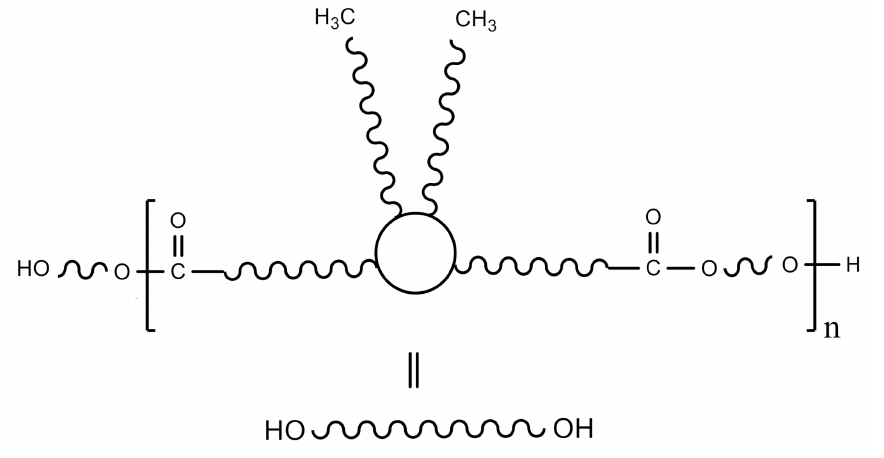
Figure 2. The chemical structure of Priplast 3294. The additives to formulate the printing pastes were supplied by Color Center, S.A. and are: Defoamer PR (defoamer, mineral oil-based), Complex DG (diethylene glycol-based, runnability improver), DMEA (dimethylethanolamine, neutralizing agent), and Thickener L-120 (polyacrylic acid, associative thickener). A commercial aliphatic polyether-urethane waterborne dispersion from Color Center, S.A., 35% solids, non-biobased, referenced as RD27, has been included in this work as a comparative